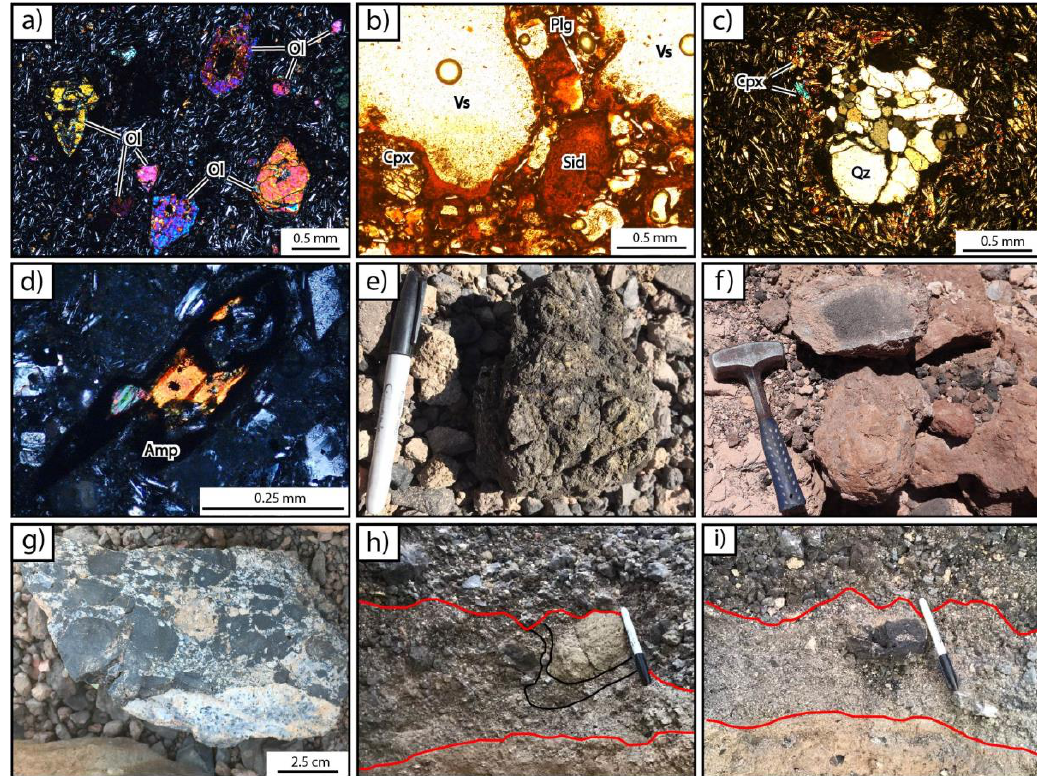
Figure 7. ( a ) Skeletal and sieve textures of olivine (Ol) phenocrysts from Cerro Overo maar [taken from 54]. ( b ) Orange-red sideromelane (Sid) associated with irregular vesicles (Vs), plagioclases (Plg), and clinopyroxenes (Cpx) from Tilocálar Sur maar (documented in detail in [53]). ( c ) Quartz (Qz) xenocrysts with well-developed acicular clinopyroxene (Cpx) reaction coronas from Tilocálar Sur maar (documented in detail in [53]. ( d ) Amphibole (Amp) breakdown/reaction rim width with skeletal and sieve textures from Cerro Tujle maar (documented in detail in [50]. ( e ) Scoria with cauliflower texture from Cerro Overo maar [taken from 54]. ( f ) Scoria with chilled margin from Tilocálar Sur maar (documented in detail in [53]. ( g ) Breccia of juvenile material from Cerro Tujle maar (documented in detail in [50]. ( h , i ) Impact of a ballistically transported fragment from Cerro Overo maar (documented in detail in [54].